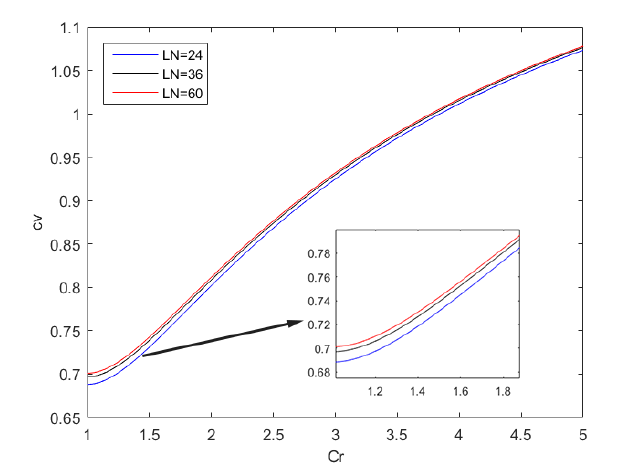
Figure 8. Variation of Cr with cv for different neighborhood